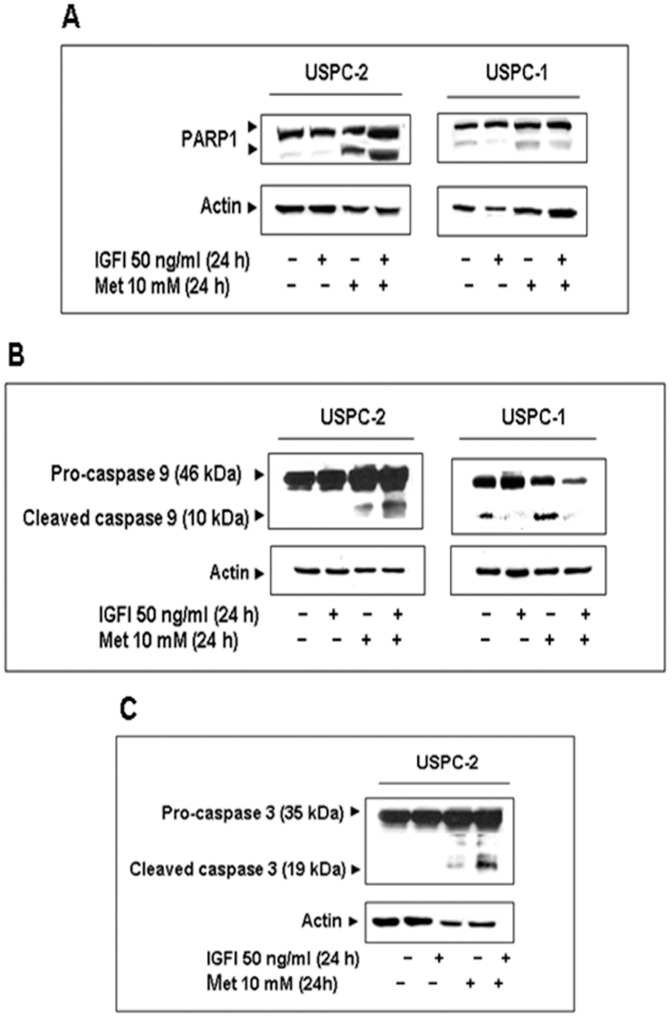
Effect of metformin on apoptosis.A, Western blot analysis of PARP1 in USPC-2 and USPC-1 cells. B, Western blot analysis of caspase 9 in USPC-2 and USPC-1 cells. C, Western blot analysis of caspase 3 in USPC-2 cells. Cells were treated with metformin for 24 h in the presence or absence of IGF-I. Whole-cell lysates (100 µg) were resolved by SDS-PAGE and immunoblotted with the indicated antibodies. Results are representative of three independent experiments.